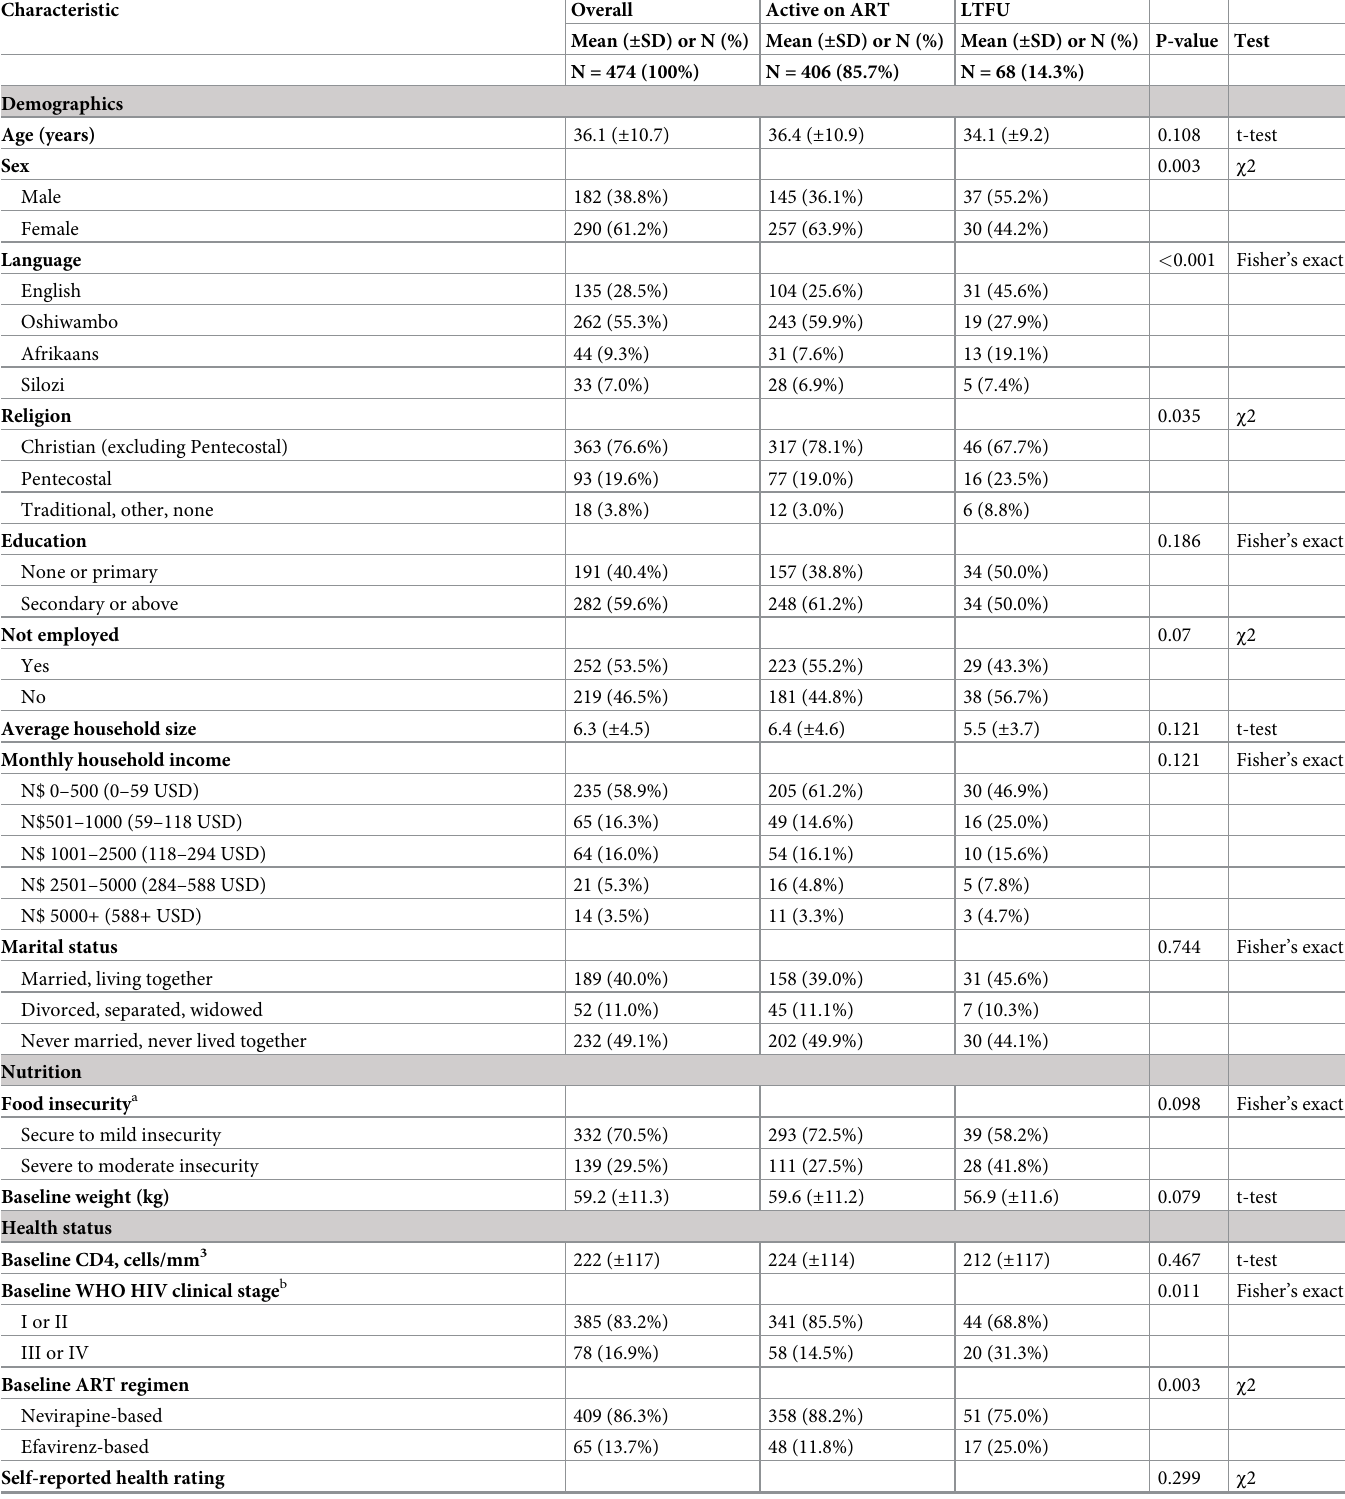
Table 1. Cohort characteristics overall and stratified into alive and active on ART versus LTFU 12 months after ART initiation.